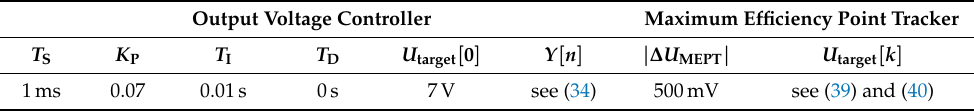
Table 3. Parameters and output quantities of the voltage controller and the MEPT